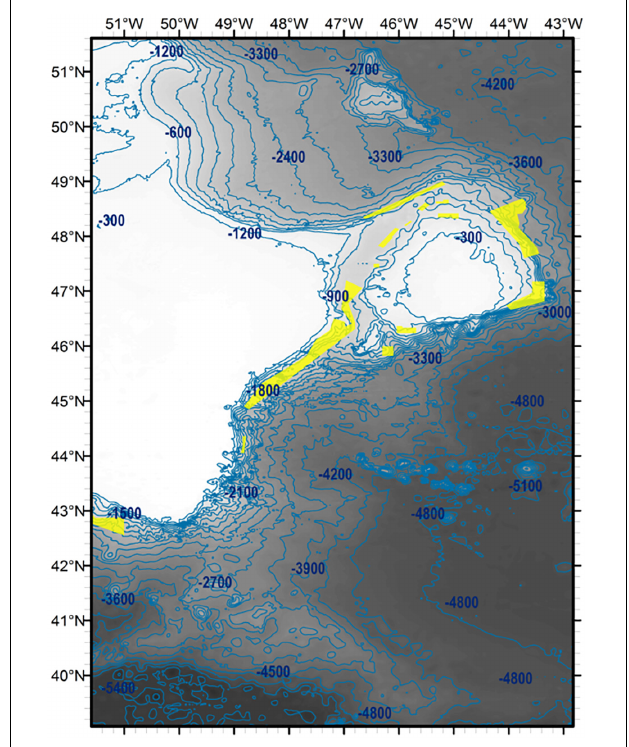
FIGURE 1 | Positions of Northwest Atlantic Fisheries Organisation Vulnerable Marine Ecosystem closures around the Flemish Cap, Flemish Pass and slopes of the Grand Banks (yellow polygons). Locations correct as of December 2016. Contours in metres. SRTM30 bathymetric data used (lighter, shallower; darker,